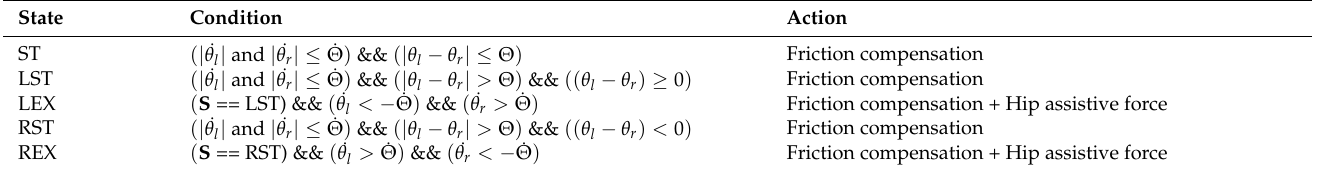
Table 1. State transition rules and